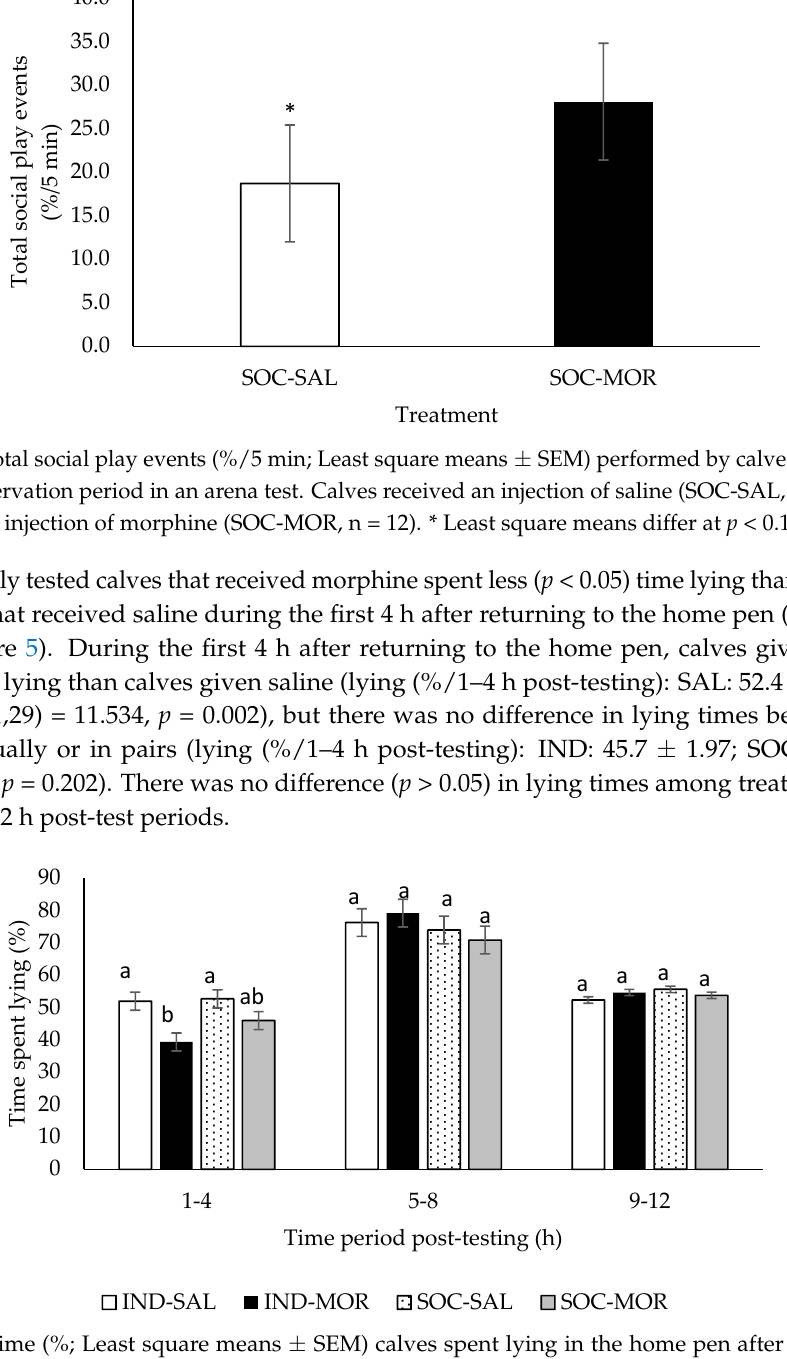
Figure 5. Time (%; Least square means ± SEM) calves spent lying in the home pen after the arena test. Calves received an injection of saline and were tested individually (IND-SAL, n = 12) or in pairs (SOC-SAL, n = 12), or received an injection of morphine and were tested individually (IND-MOR, n = 12) or in pairs (SOC-MOR, n = 12). For each time category, least square means with different superscripts differ at p <